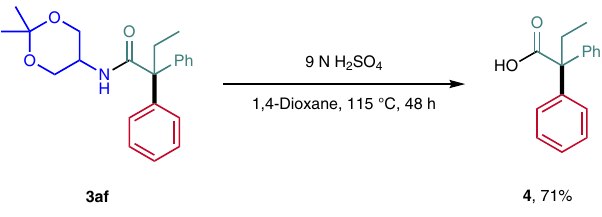
Fig. 5 Follow-up chemistry. Acidic hydrolysis of amide 3af